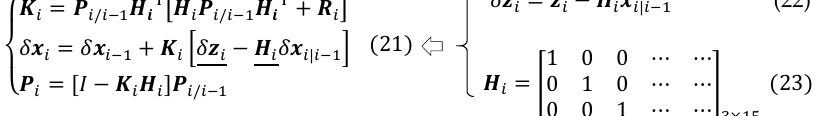
Figure 2. Summary of the process procedures of the GNSS/IMU-P40 coupled navigation.